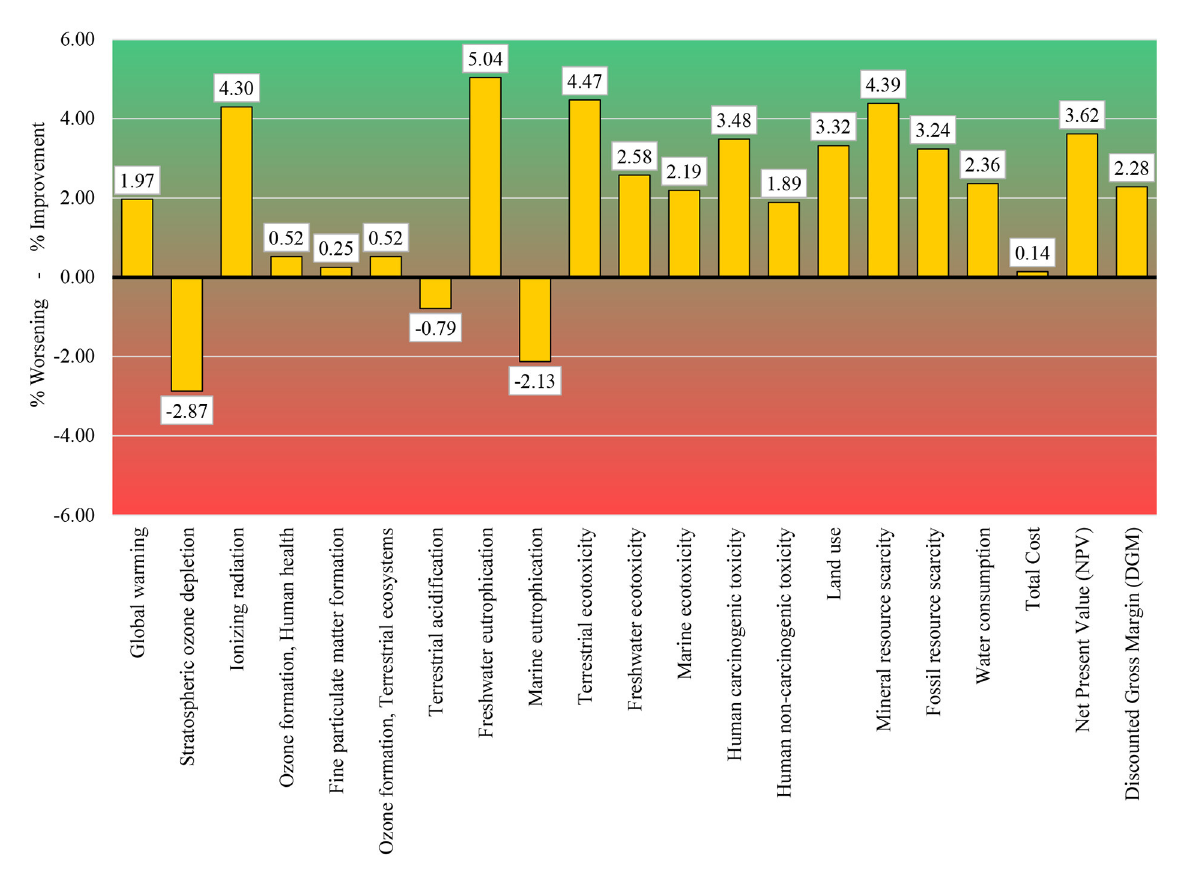
FIGURE5 Marginal percentage variation, from the linear scenario (baseline), for each LCA and LCC indicator (Source: Authors’